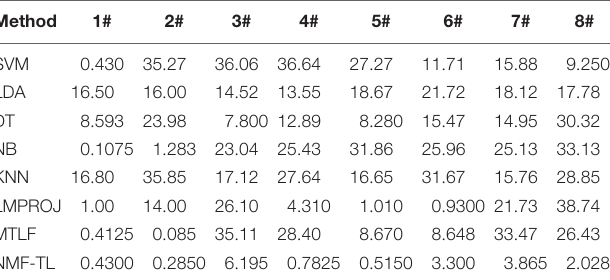
TABLE 13 | Friedman values for 8 different methods on datasets based on SIFT feature extraction.